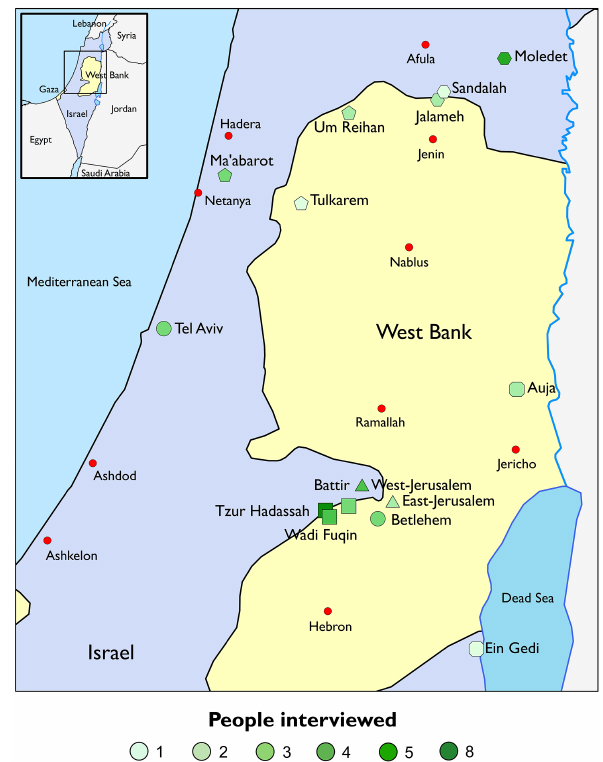
Figure 1. Locations of the interviews with GWN